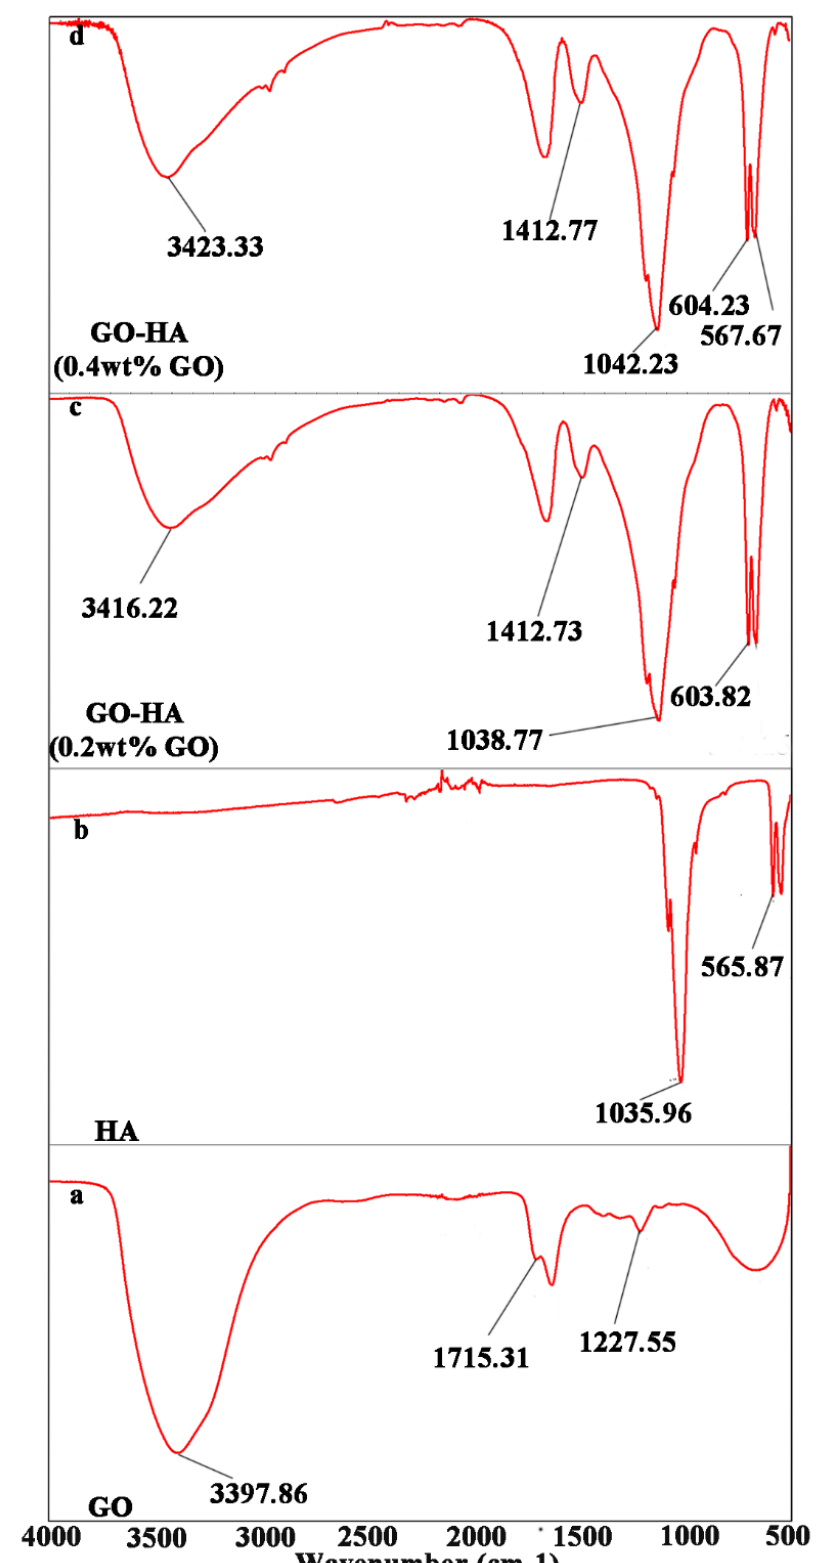
Figure 1. Fourier transform infrared (FTIR) spectroscopy evaluation of graphene oxide (GO; a ), hydroxyapatite (HA; b ), GO–HA (fabricated with 0.2 wt% GO; c ) and GO–HA (fabricated with 0.4 wt% GO; d ).